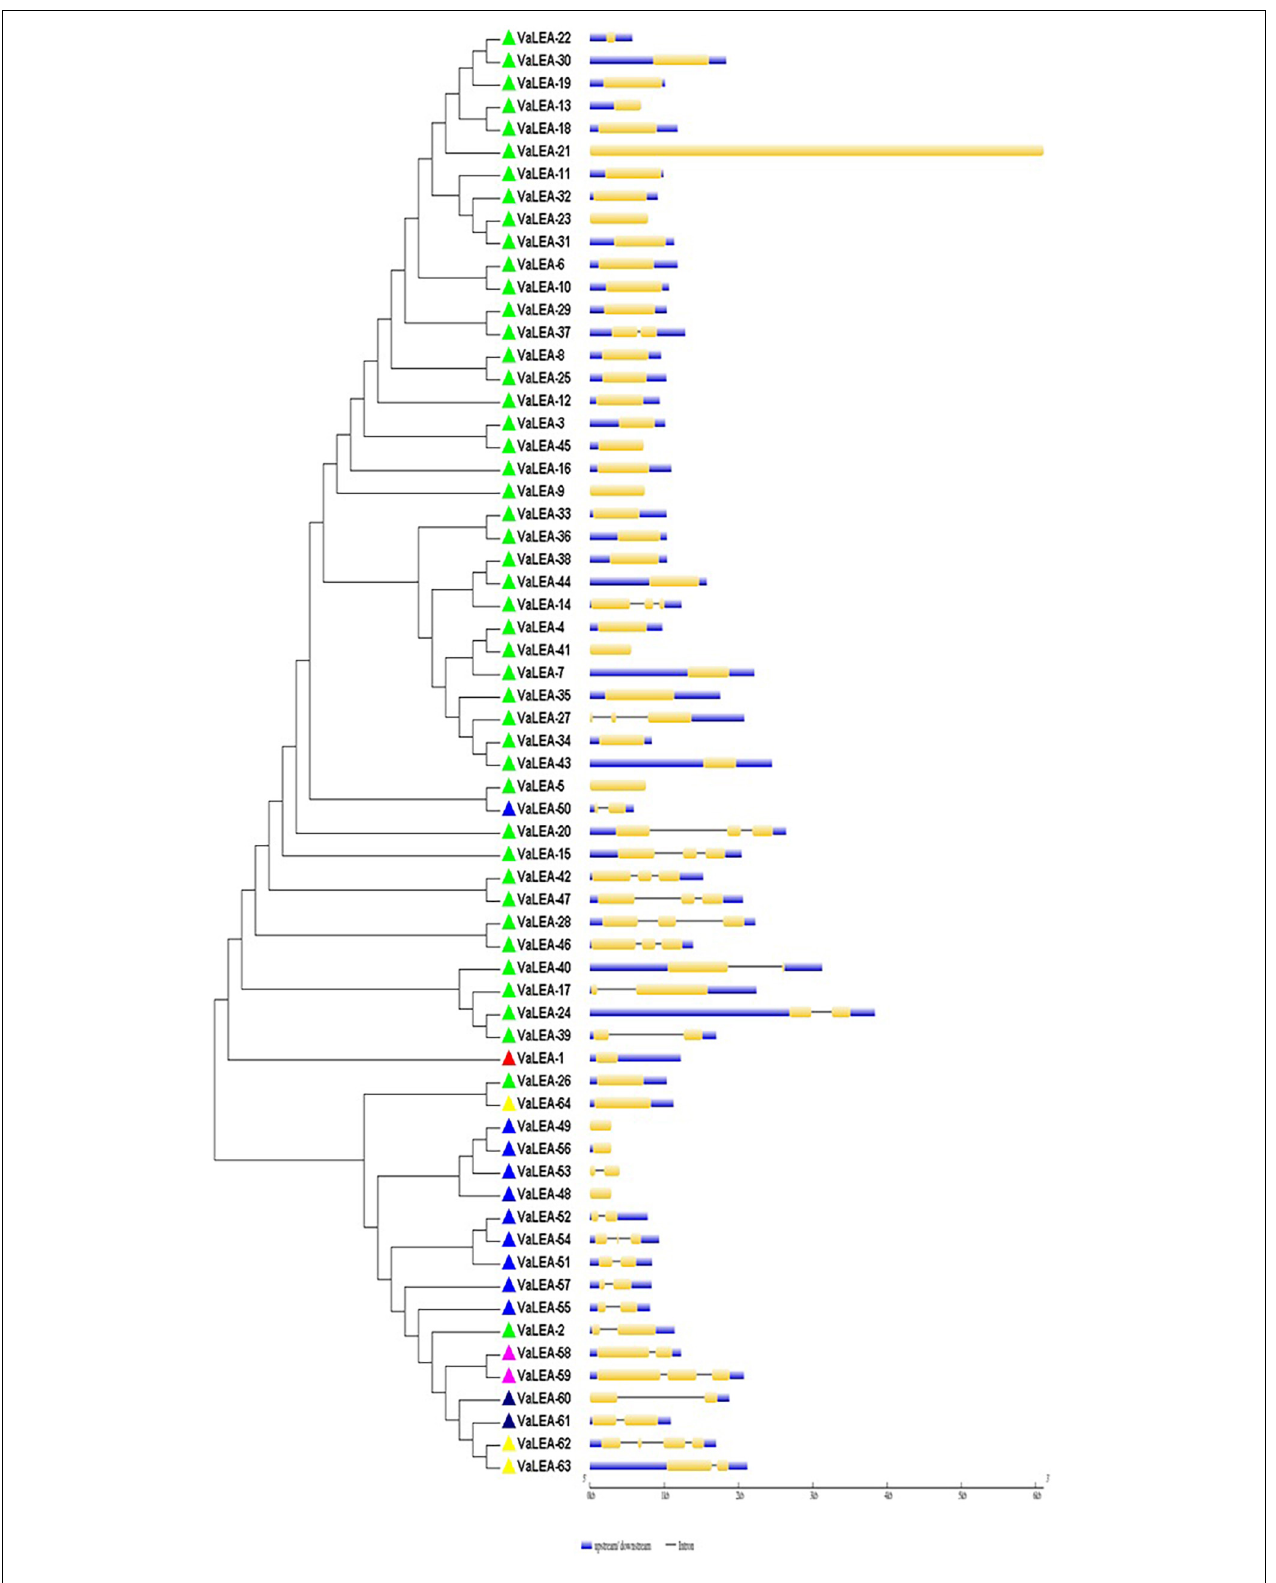
FIGURE 4 | Intron-exon gene structure analysis of VaLEA genes.